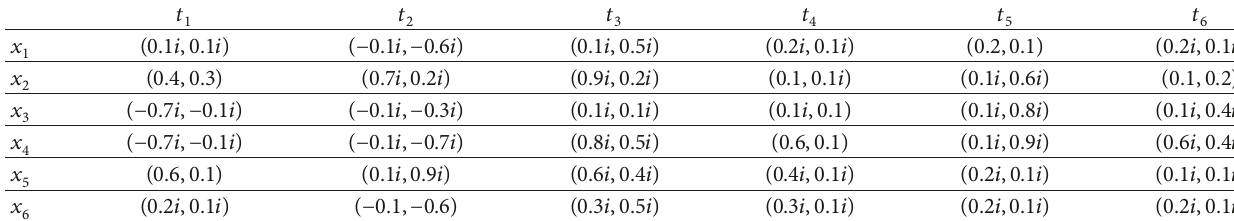
Table 16: TCIFS B (𝑇)